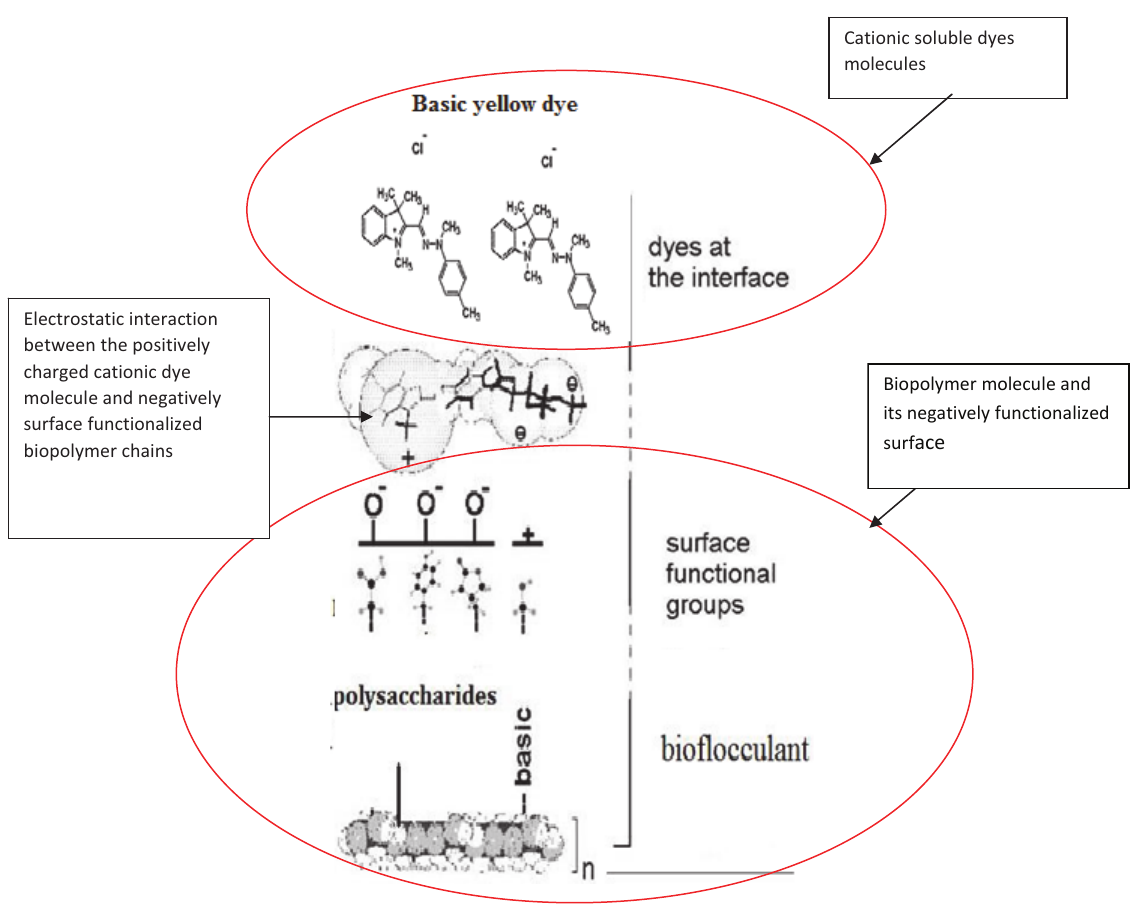
Fig. 3 Model depicting the interaction between cationic dye molecules and biopolymer surface